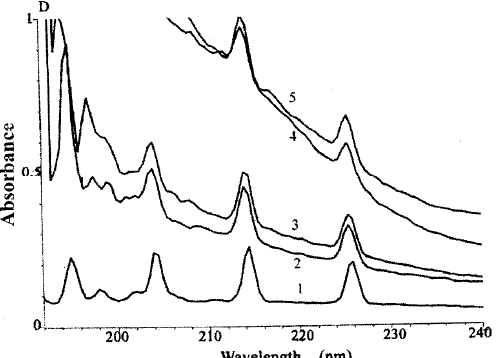
Figure 15. Change of optical absorption of gaseous NO released from B-DNIC-GSH solution (8 mmol in 16 mL) in 200 mmol HEPES buffer, pH 7,4. During decomposition of the complex in the Thunberg apparatus caused by adding 80 mmol FeCN to the solution. Curves 2 and 3—NO absorption bands in 15 and 20 min after adding FeCN at 60 °C. Curves 4 and 5—the first two of the four NO absorption bands, registered in the same Thunberg apparatus after pumping NO out of it and then adding sulfuric acid to the solution in 15 and 20 min. Curve 1—the absorption spectrum of a standard sample of gaseous NO (125 μ mol in 100 mL of free volume of the Thunberg apparatus) [87]. (With permission).